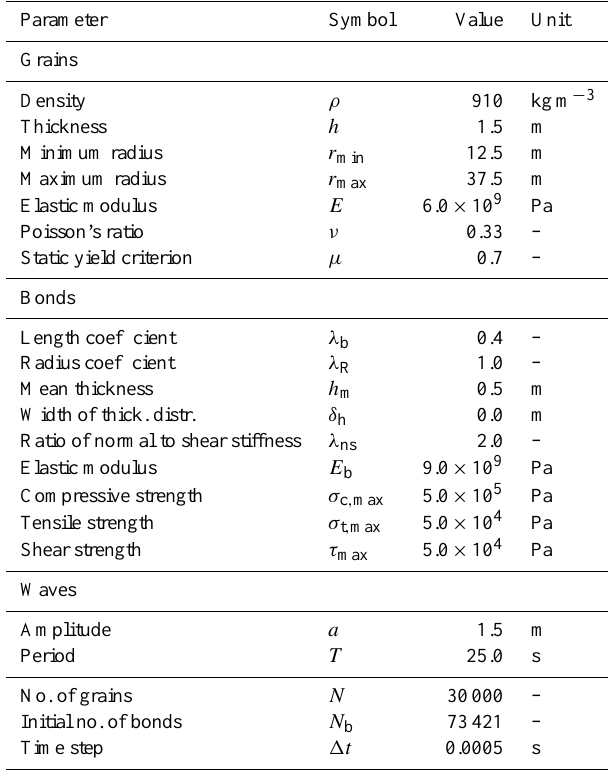
Table 3. Physical and numerical model parameters used in the ref- erence simulations in Sect.